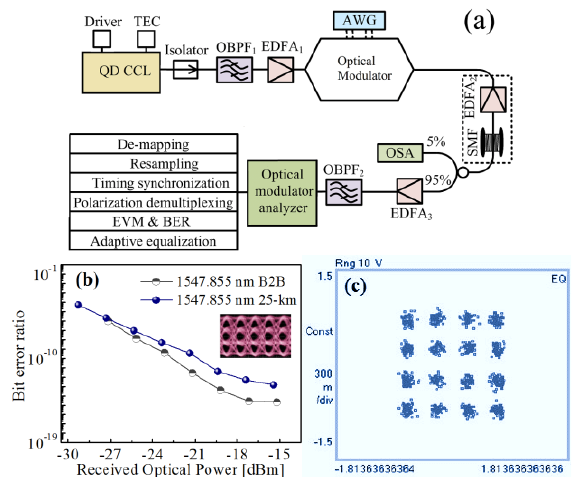
Fig. 3 (a) A schematic of PAM 4 and QAM data format system. (b) Measured BER versus received power for PAM 4 B2B and after 25-km of SMF transmission using a comb line of 1547.855 nm of 34.5 GHz QD MWL. The inset shows corresponding eye diagram for 25-km of SMF transmission. (c) A constellation eye diagram obtained from filtered channel of 1544.16 nm for the 25 GHz QD MWL in the double polarization 16-QAM data format at 23 GBaud B2B transmission.